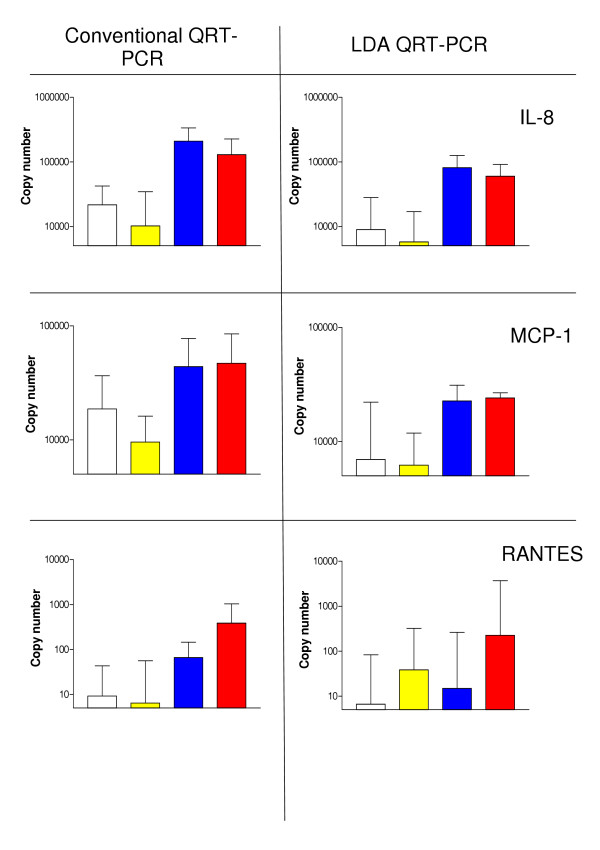
IL-8, MCP-1 and RANTES expression in human aortic endothelial cells measured using Conventional- and LDA-QRT-PCR. White bar; control-2 hrs. Yellow bar; control-12 hrs. Blue bar; thrombin-2 hrs. Red bar; thrombin-12 hrs. Each bar represents the geometric mean copy number (n = 3) +95 % CI.